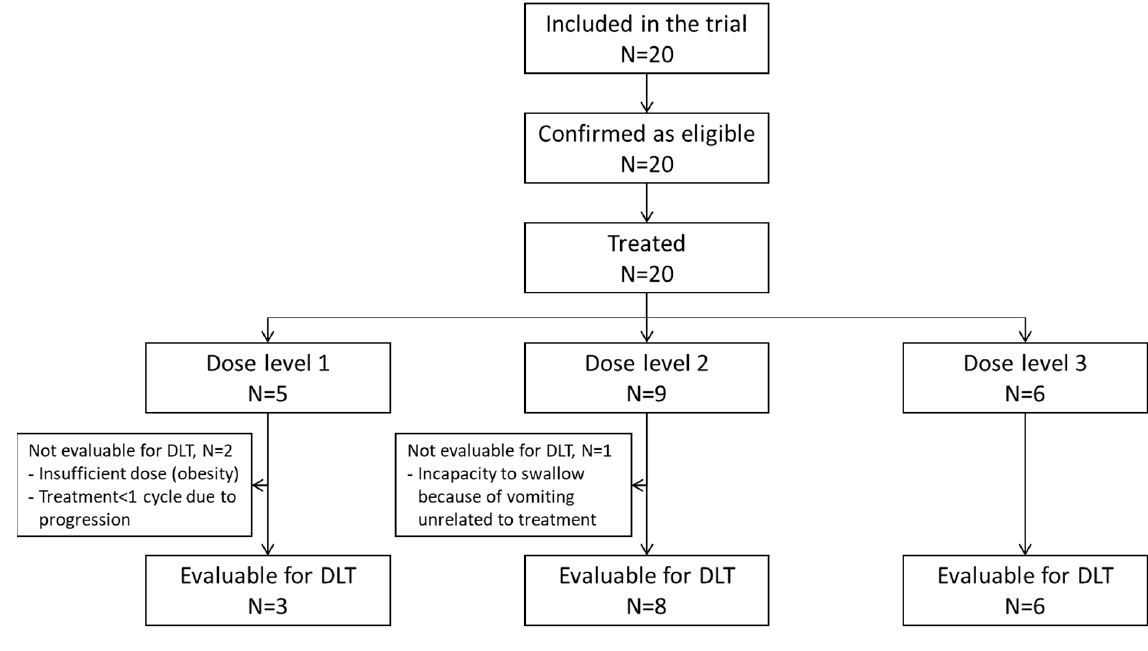
Figure 1. CONSORT diagram.